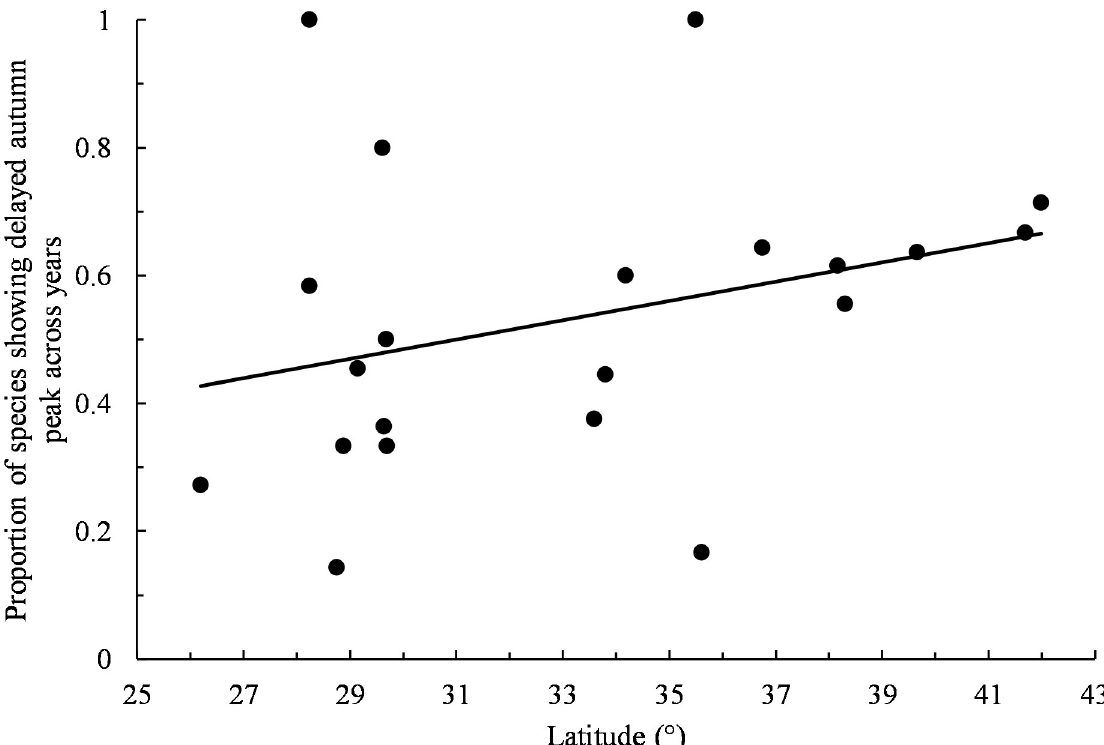
Fig 3. Proportion of species showing delayed autumn peak across years by refuge latitude. Only non-zero slopes were included. Trend line obtained by least squares linear regression.